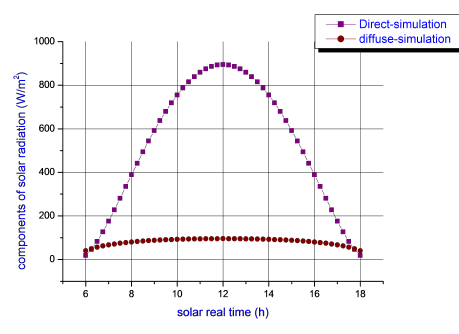
Fig. 5: Direct and di(cid:27)use component by simulation.